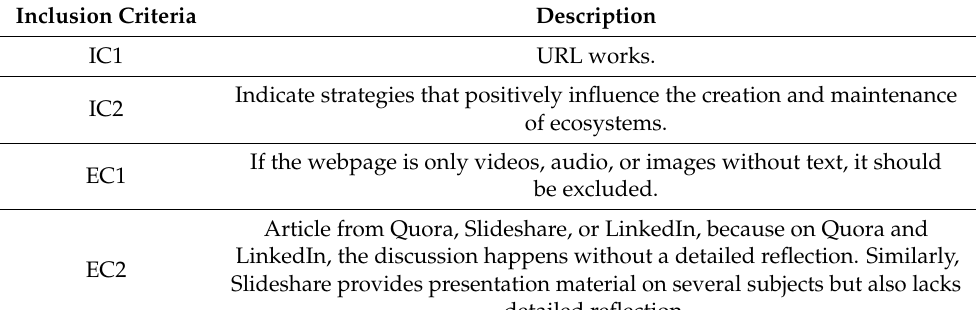
Table 1. Inclusion and exclusion